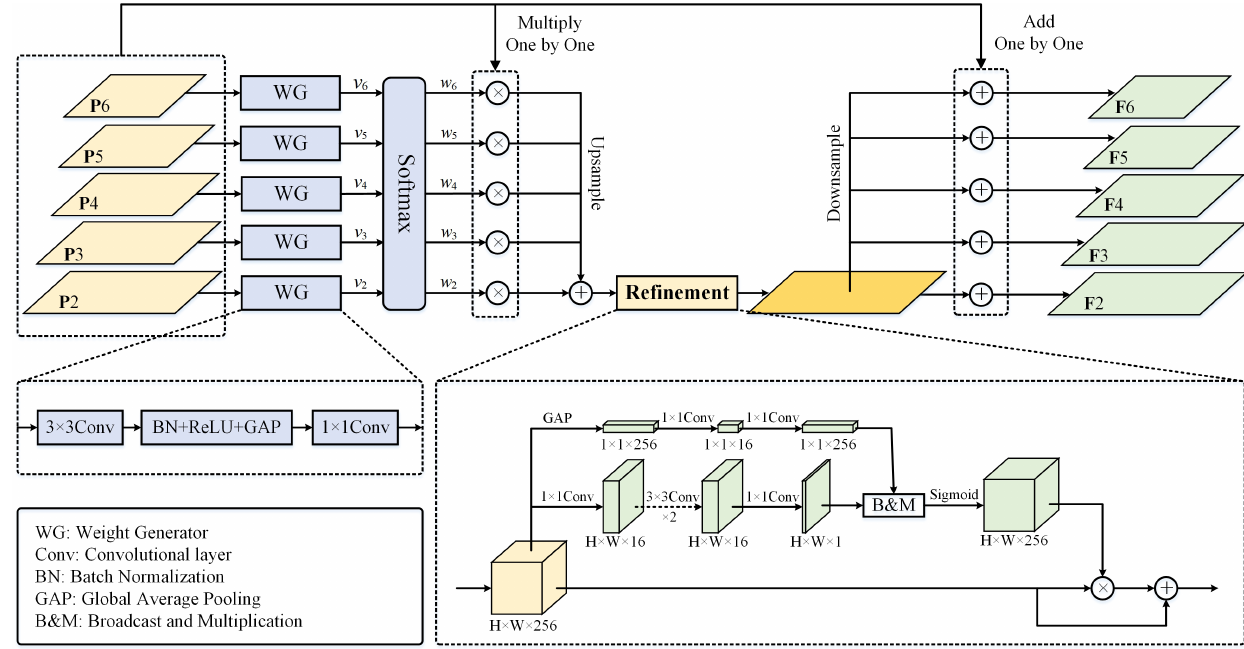
Figure 2. Illustration of our proposed WFR